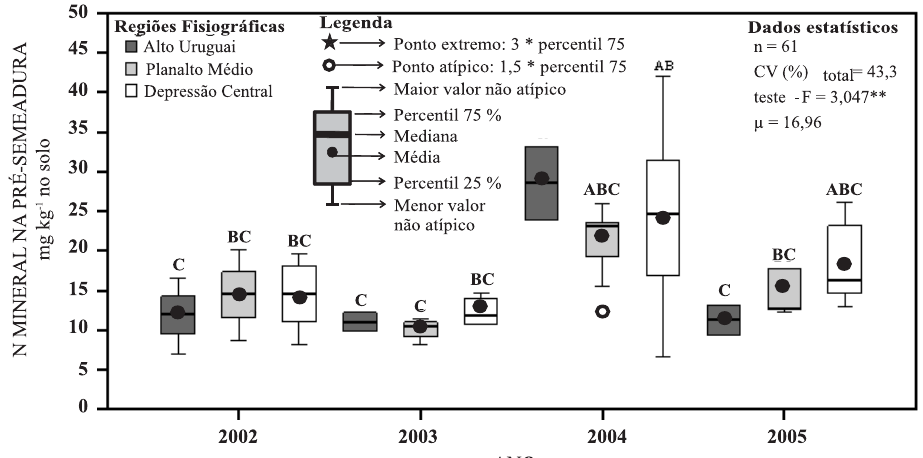
Figura 2. Distribuição dos teores de N mineral na pré-semeadura da cevada, por Regiões Fisiográficas, ao longo dos anos (ambientes). Letras maiúsculas dispostas na horizontal comparam médias entre os ambientes. Médias acompanhadas por mesma letra não diferem entre si pelo teste de Duncan a 5